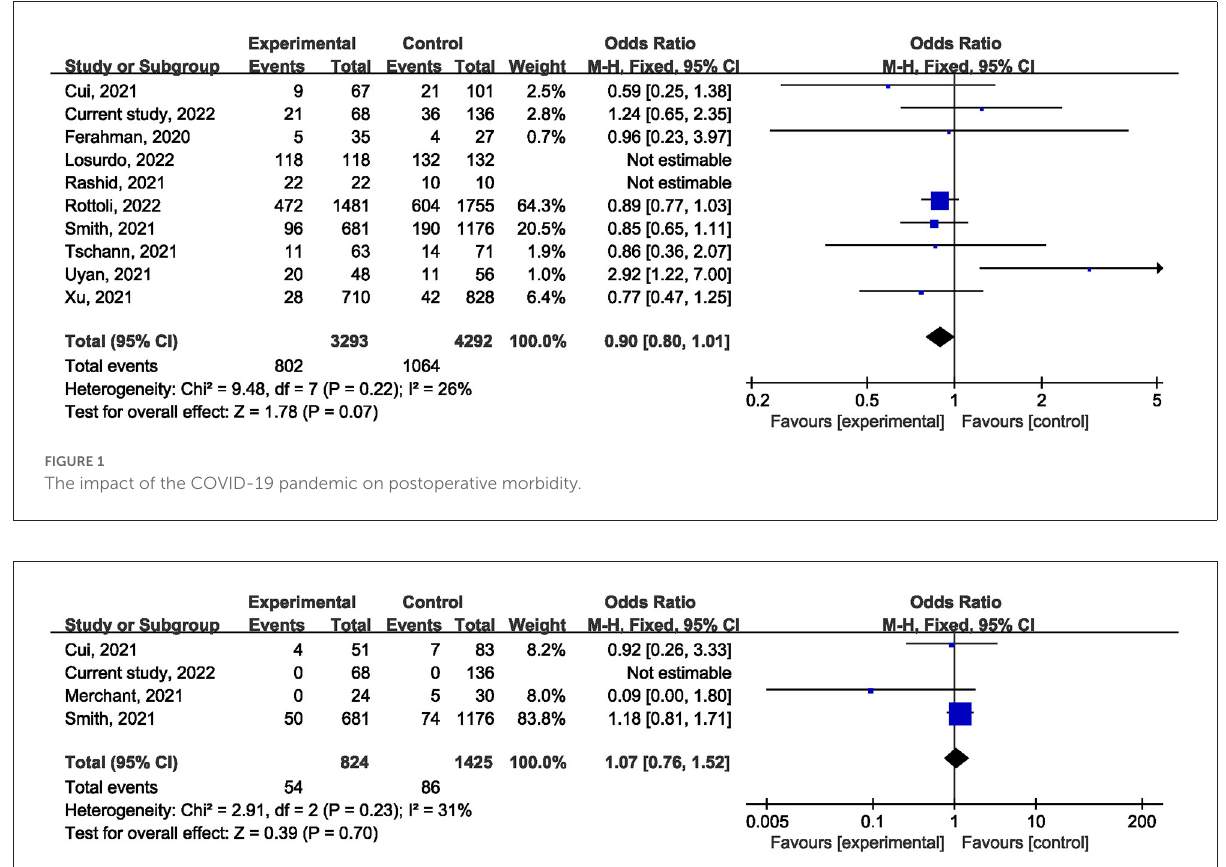
FIGURE2 The impact of the COVID-19 pandemic on the conversion rate.